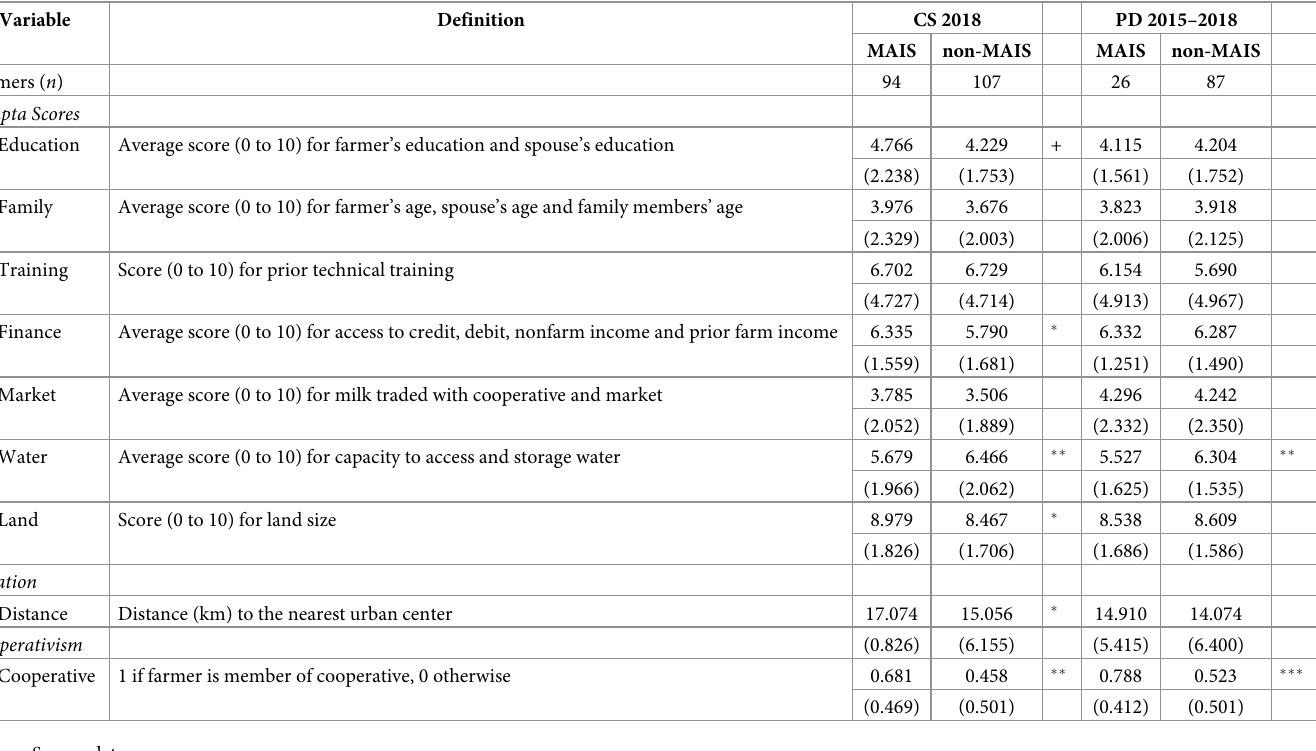
Table 2. Average values of explanatory variables (standard deviation between